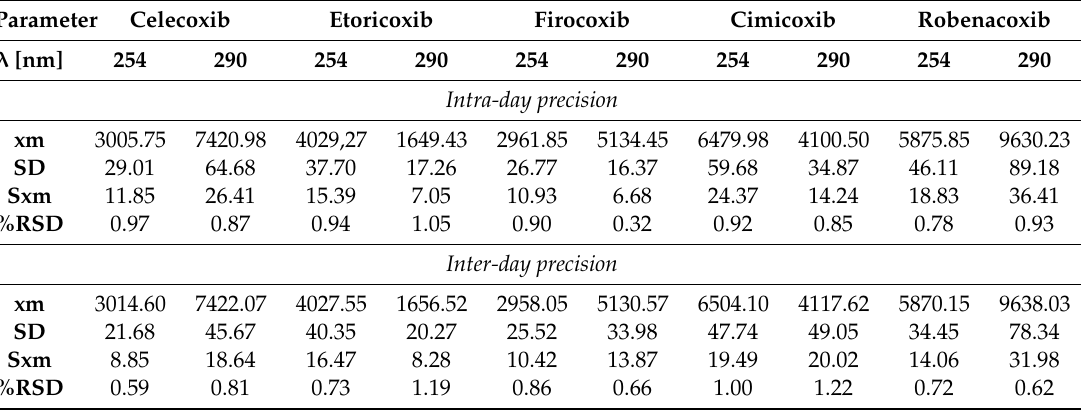
Table 3. Results of the method